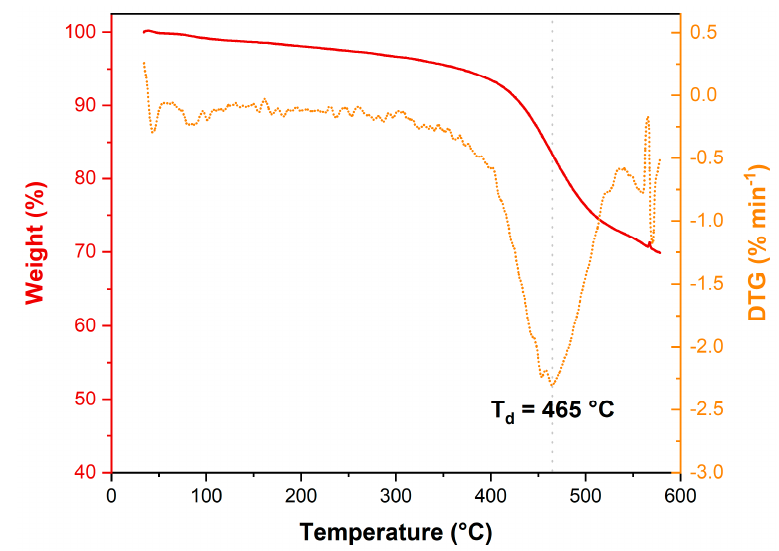
Figure 6. Thermogravimetric curves obtained for FPOP upon heating at a rate of 10 °C min − 1 . The decomposition temperature was determined as inflection point, which corresponds to the peak of the first derivative curve of the TGA (DTG).